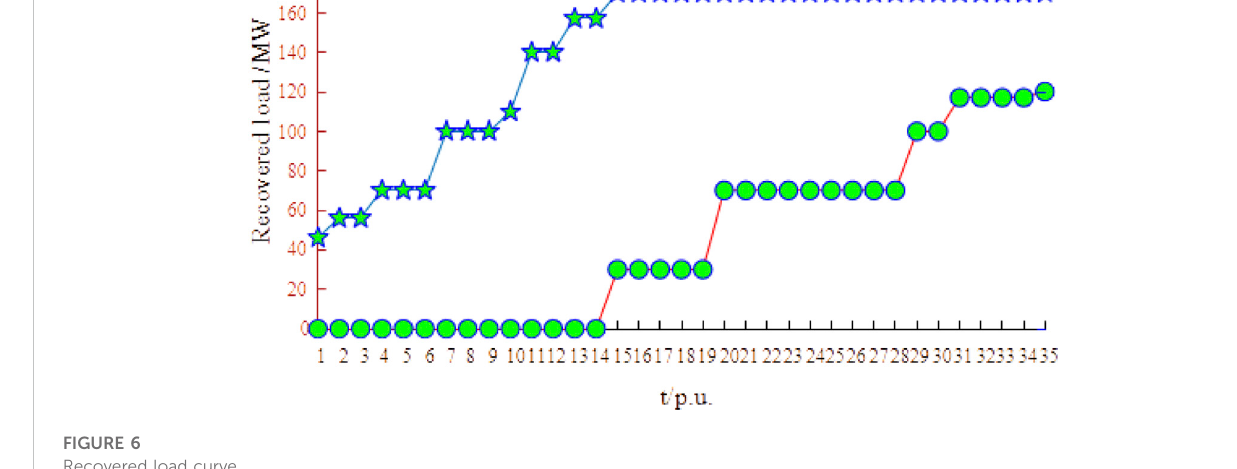
FIGURE 6 Recovered load